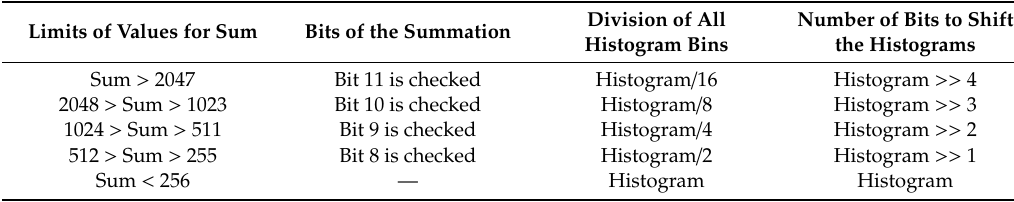
Table 2. Block normalization decoding method.